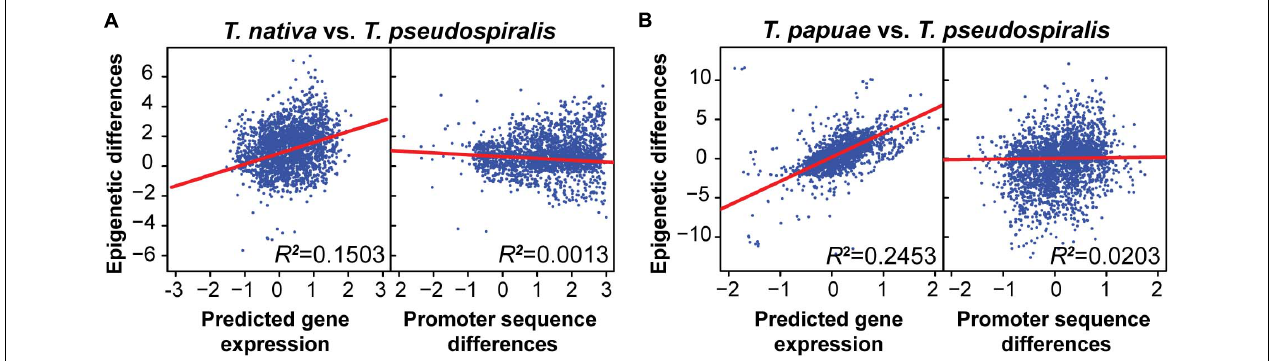
FIGURE 3 | Interspecies methylome conservation is a regulatory mechanism of transcription across Trichinella spp. Correlations among DNA methylation changes, gene expression alterations, and sequence differences in T. nativa (A) and T. papuae (B) when comparing with reference species T. pseudospiralis . Epigenetic differences were computed using the P -values generated by comparing the common methylated CpGs of orthologous genes between the two species under consideration. Predicted gene expression differences of every gene were regressed to the DNA methylation level of the upstream 2-Kb region of the gene. Sequence differences were estimated using blastn score differences by comparing differences between the maximum log blastn score of all orthologous promoters (4,000 bp centered at transcriptional start sites) and the blastn score of the orthologous promoter pair under consideration. R 2 , square of the sample correlation coefficient.